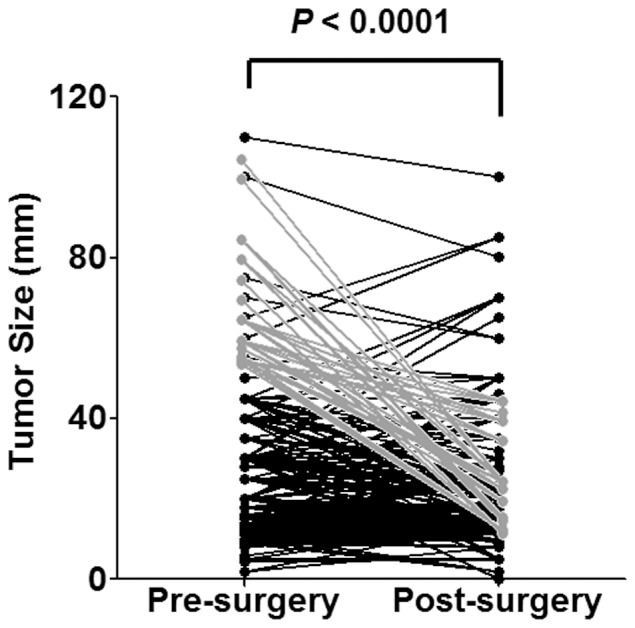
Paired t-test of pre- and post-surgical tumor sizes in 1296 breast cancer patients.Gray dots and lines indicated 92 patients with preoperative diameters >50 mm and postoperative <50 mm.